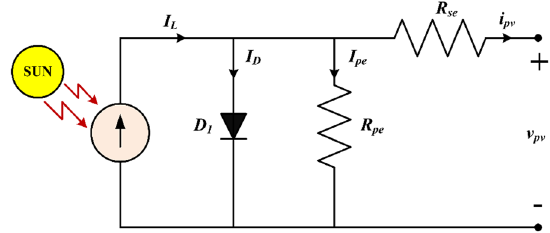
Fig. 2 Electrical equivalent circuit of a PV